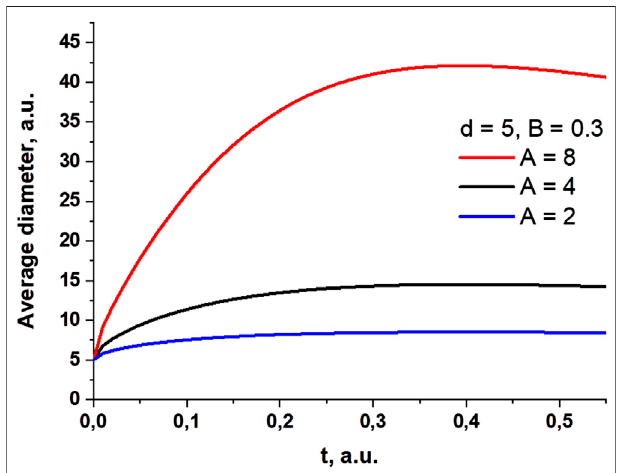
FIGURE 9 | Changes in particle size distribution when changing parameters corresponding to changes in particle